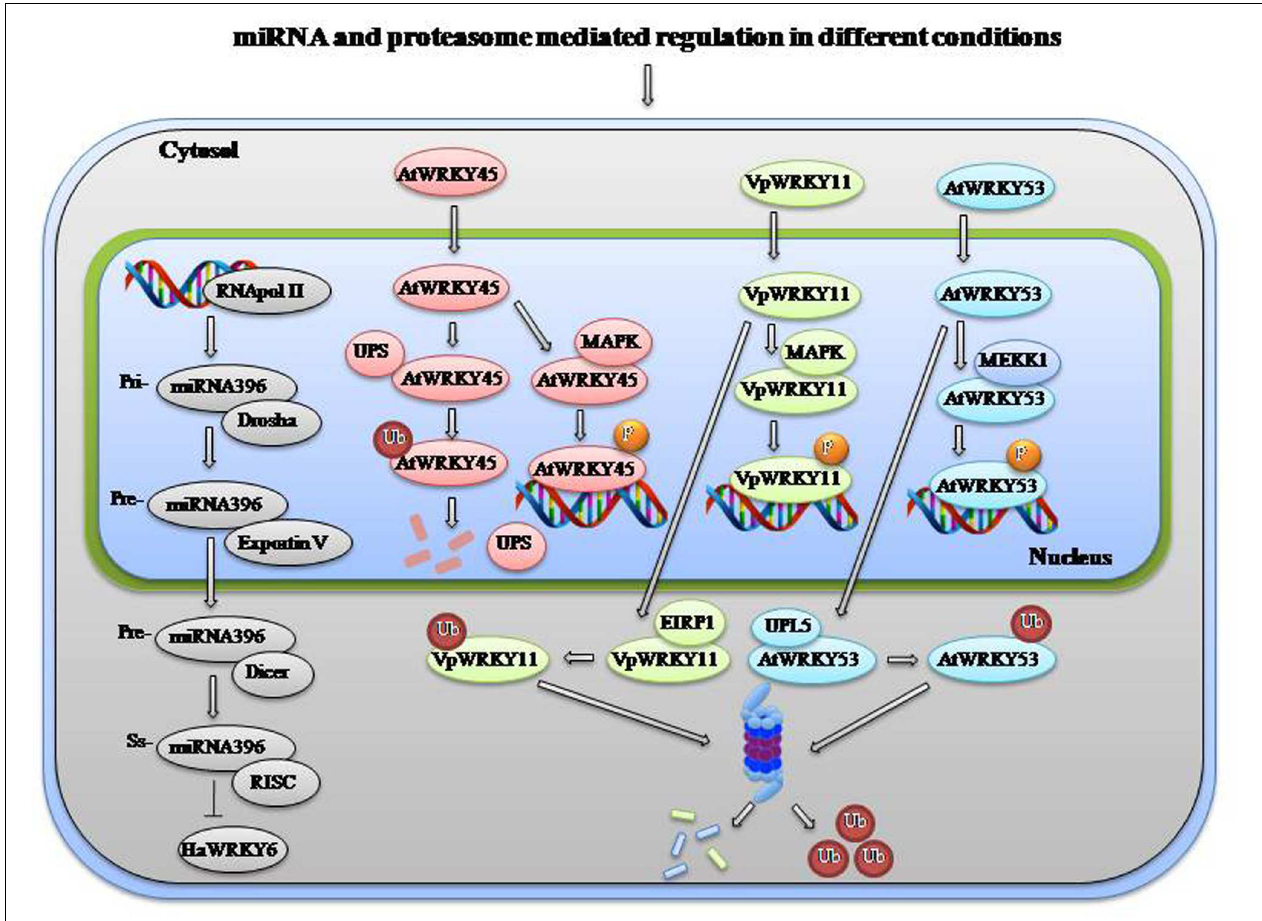
FIGURE 2 | miRNA and proteasome mediated degradation of WRKYs in different conditions. Under normal condition, stress responsive WRKYs are tightly regulated by various mechanisms and after getting stress stimulus they are phosphorylated/activated by different mechanisms to regulate downstream genes. miRNA either lead to degradation or translational inhibition of WRKYs to regulate unwanted expression. An example of regulation/degradation of HaWRKY6 by miR396 cascade is shown. Also proteasome mediated degradation of AtWRKY45, VpWRKY11, and AtWRKY53 by UPS, EIRP1, and UPL5 has been shown, respectively. Single color has been given to all the factors involved in a paricular cascade. After onset of stress these WRKYs are phosphorylated by different MAPKs and they in turn regulate expression of downstream stress responsive genes. Abbreviations: UPL5: Ubiquitin protein ligase 5, UPS: nuclear ubiquitin-proteasome system, EIRP1: Erysiphe necator-induced RING finger protein 1, MAPK, Mitogen-activated protein kinase; Ub, Ubiquitin; RISC, RNA isolated silencing